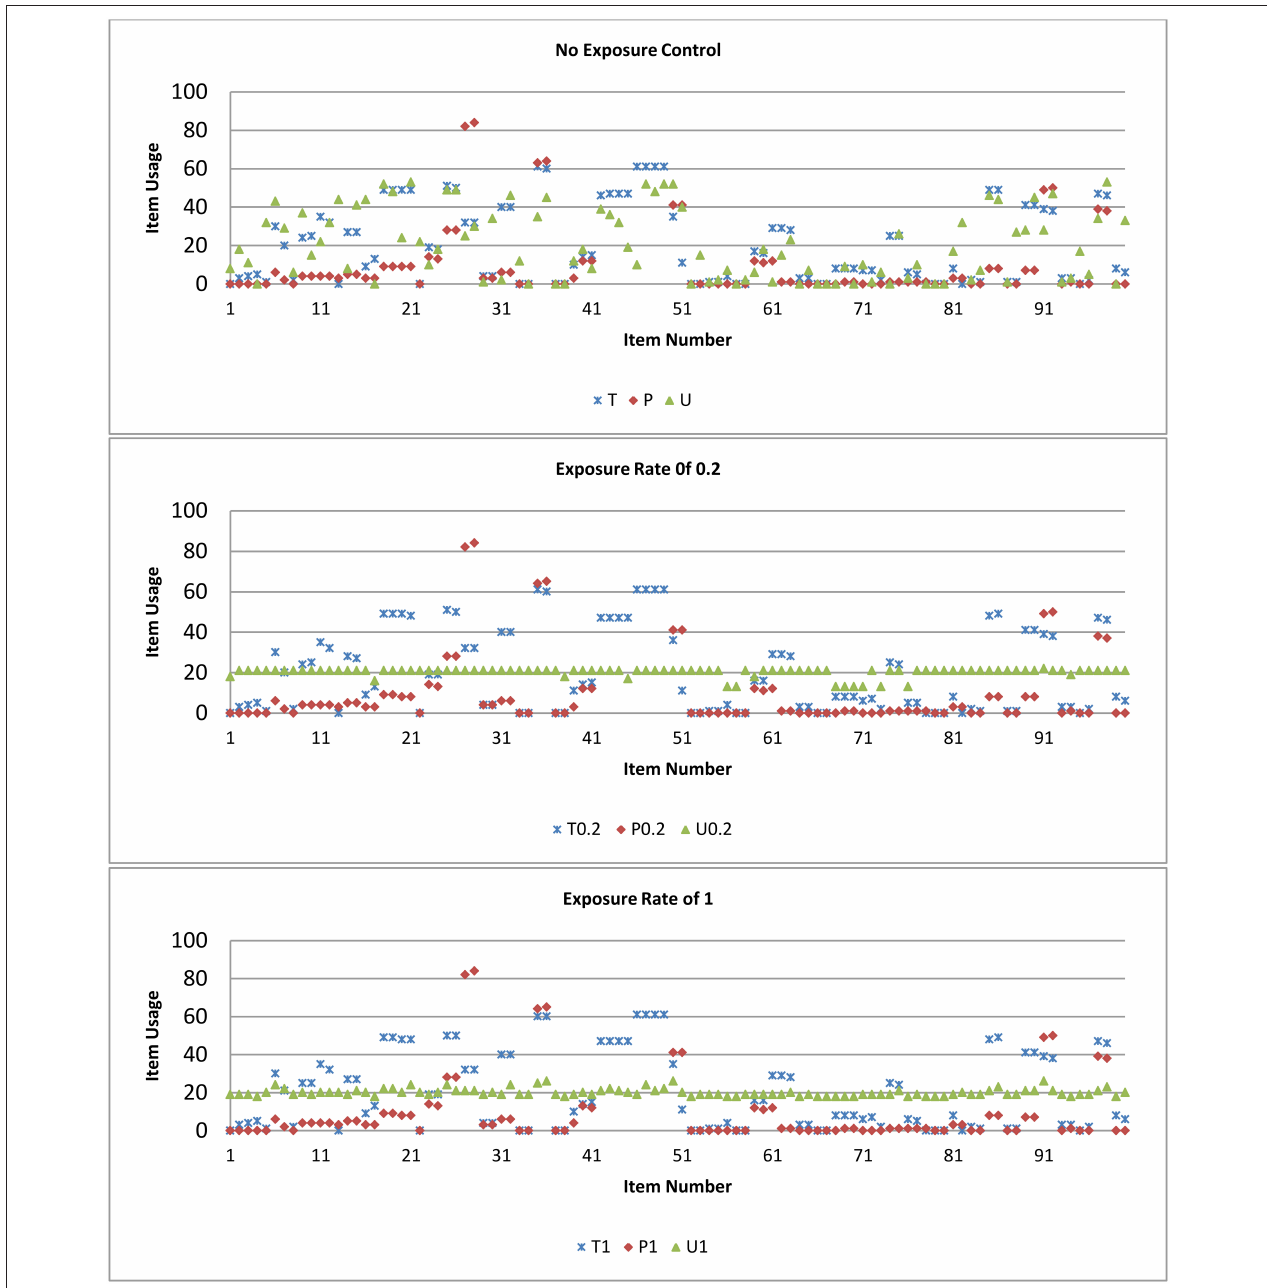
FIGURE 5 | Item usage rate for the three methods T, P, and U for conditions of item exposure rate of 0.2, 1, and no exposure control for test length of 30 for selection method M2.